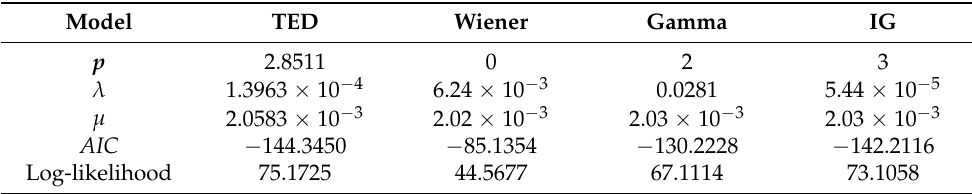
Table 7. AIC and log-likehood of different models for the GaAs laser data.